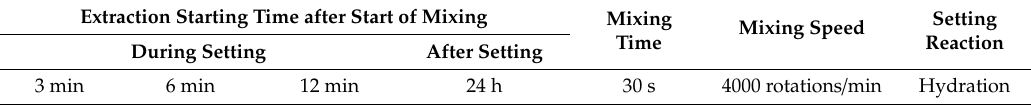
Table 2. Experimental conditions of Biodentine ™